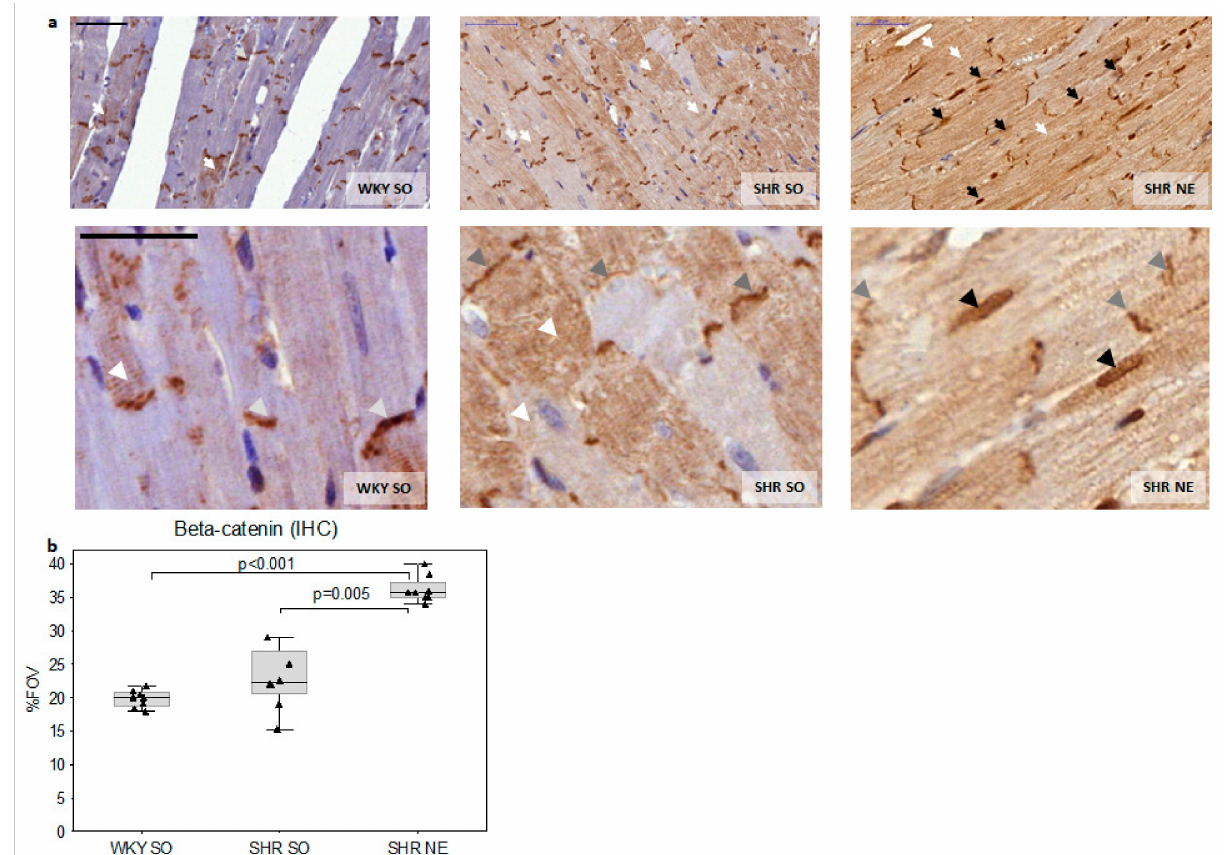
Figure 2. Myocardial expression of β -catenin (IHC): ( a ) representative microphotographs of myocardial β -catenin IHC staining in WKY-SO, SHR-SO, and SHR-NE groups (white arrows—the cytoplasmic expression; grey arrows—intercalated discs; black arrows—the nuclear expression; scale bar, 50 um); ( b ) the total area of myocardial β -catenin expression; WKY—Wistar Kyoto rats; SHR—spontaneously hypertensive rats; SO—sham-operated; NE—nephrectomy; FOV—field of